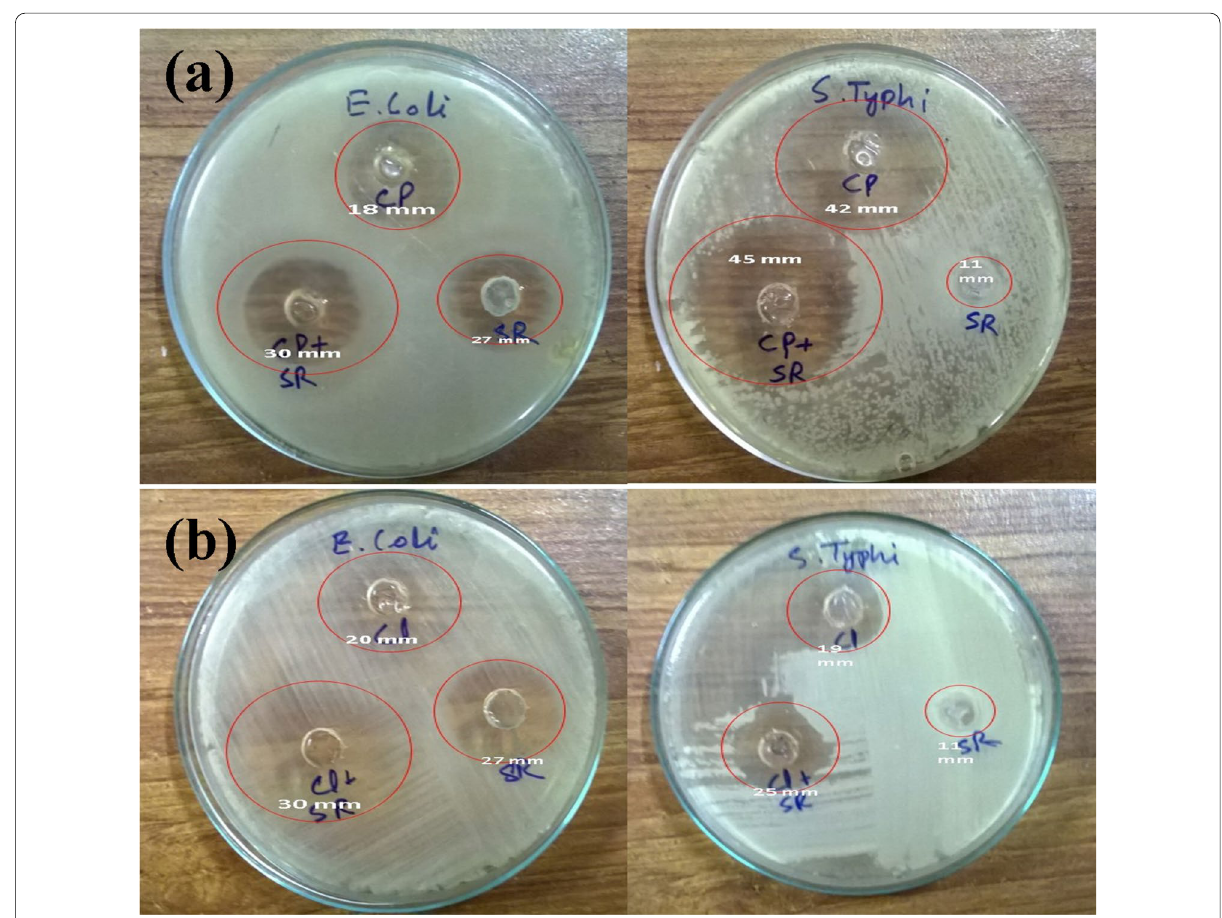
Fig. 3 Antibiogram of crude lipopeptide extract tested with antibiotics a ciprofloxacin and b clarithromycin, against Escherichia coli and Salmonella